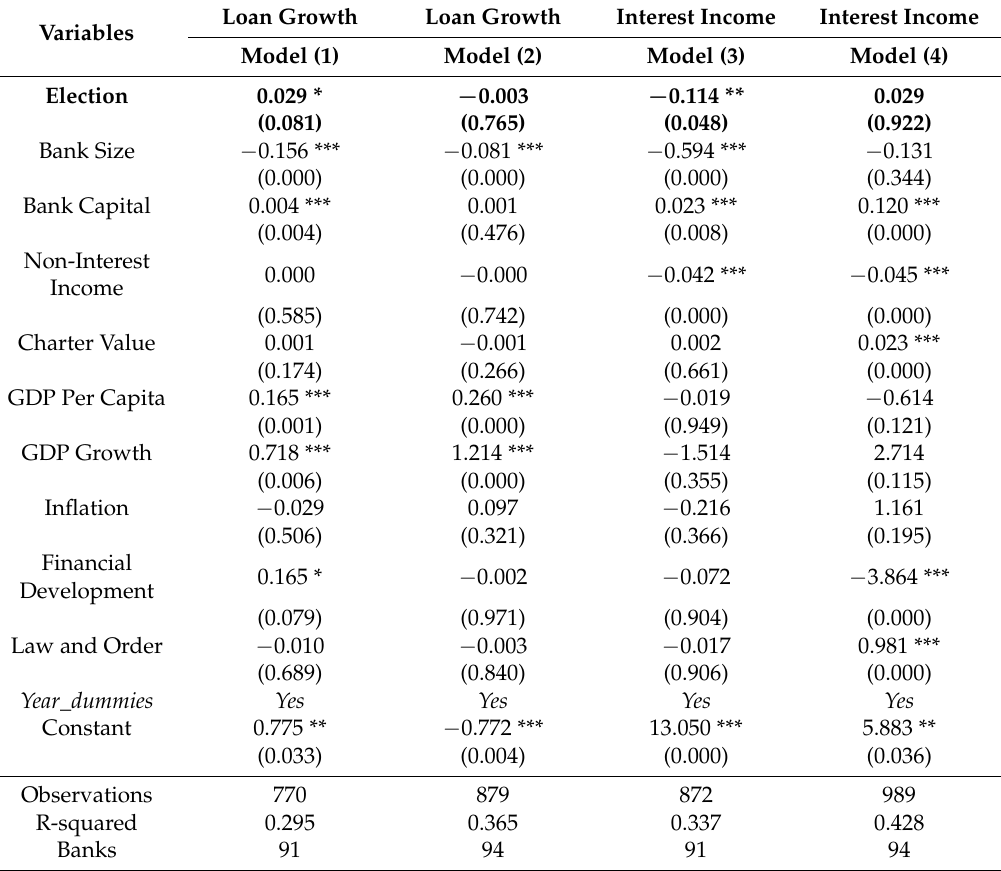
Table 6. Political institutions and political pressure on state-owned banks (Alternate proxy of political